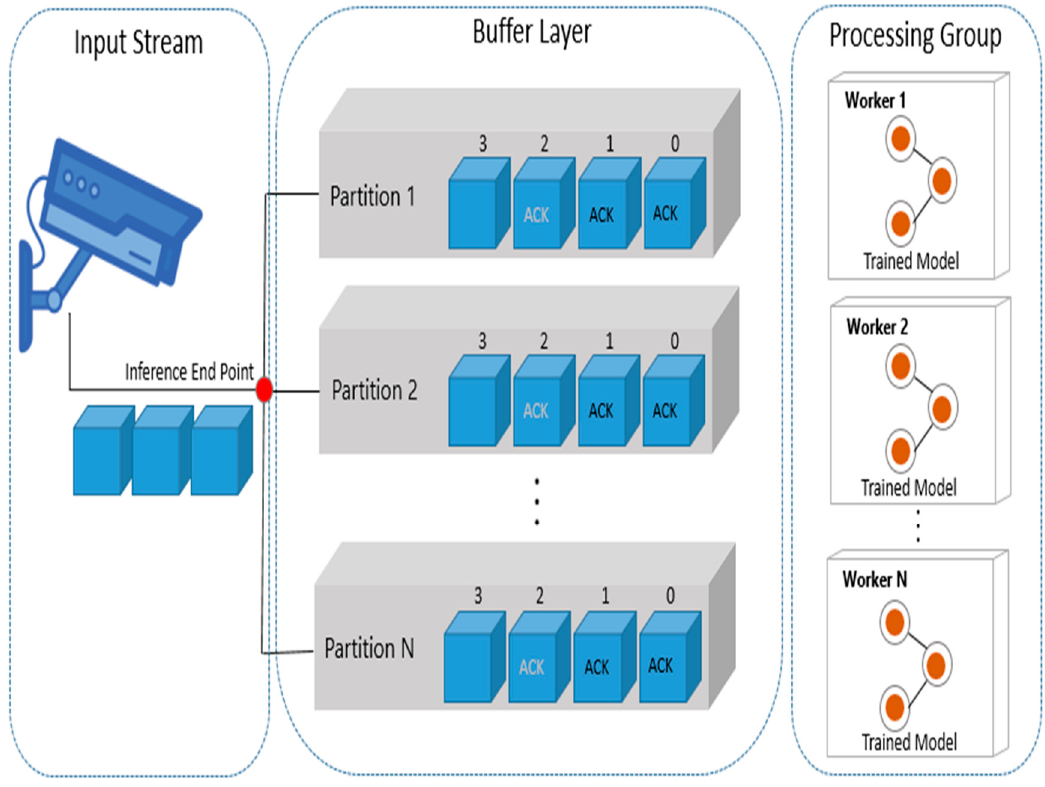
Figure 1. Methodology for real-time model inference in DiPLIP.